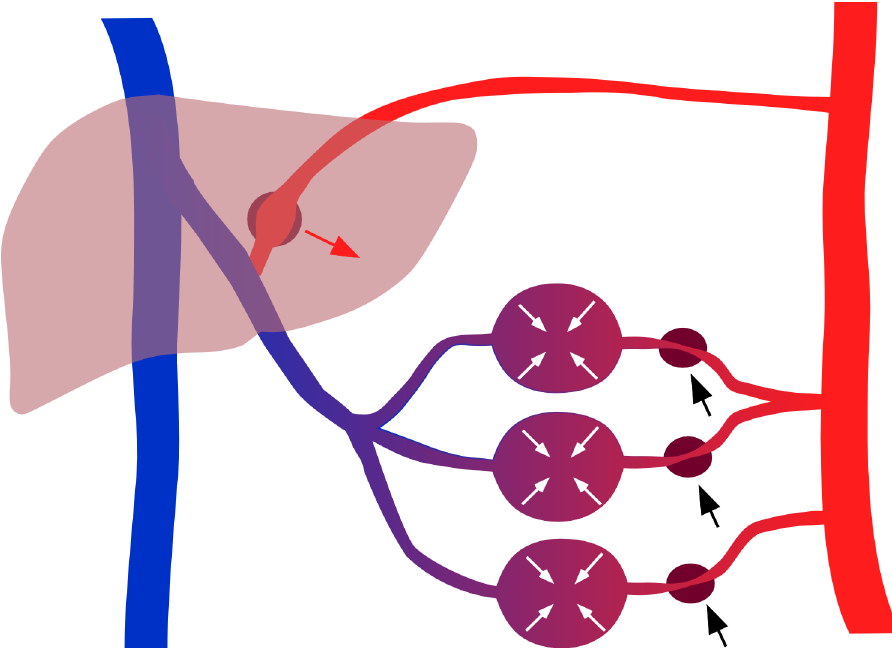
Fig 3. Scheme of hepato-splanchinc contribution for hemodynamic stability. Splanchnic vasoconstriction reduces arterial inflow (black arrows) thereby lowering downstream distending pressures and mobilizing blood volume (white arrows) sequestered in the compliant splanchnic vasculature. At the same time reduced portal vein flow draining form splanchnic vascular beds (purple) causes a compensatory increase (red arrow) in the separate hepatic arterial blood flow (red) because of compensatory vasodilation in Mall´s space.